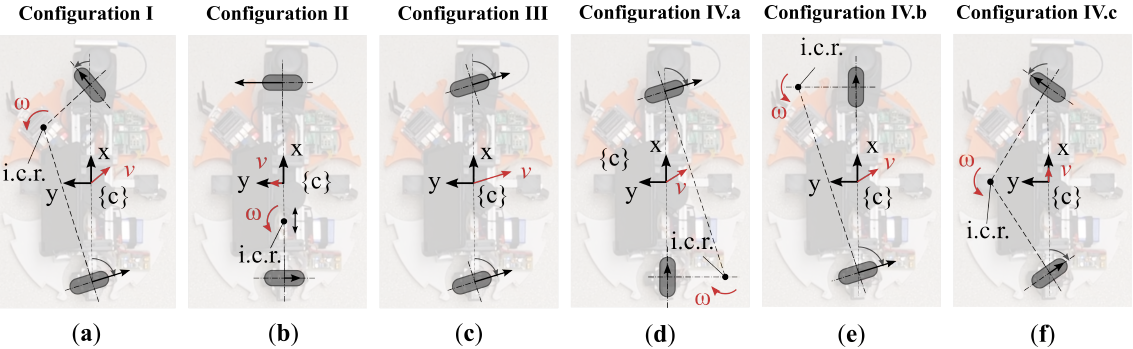
Figure 2. Main locomotion strategies that could be implemented for the PAQUITOP pseudo- omnidirectional platform: ( a ) general motion is achieved through the independent control of the 2 steering angles; ( b ) differential drive motion; ( c ) pure transnational motion; ( d ) car-like locomotion with a front steering wheel; ( e ) car-like locomotion with a rear steering wheel; ( f ) car-like locomotion with two steering wheels.